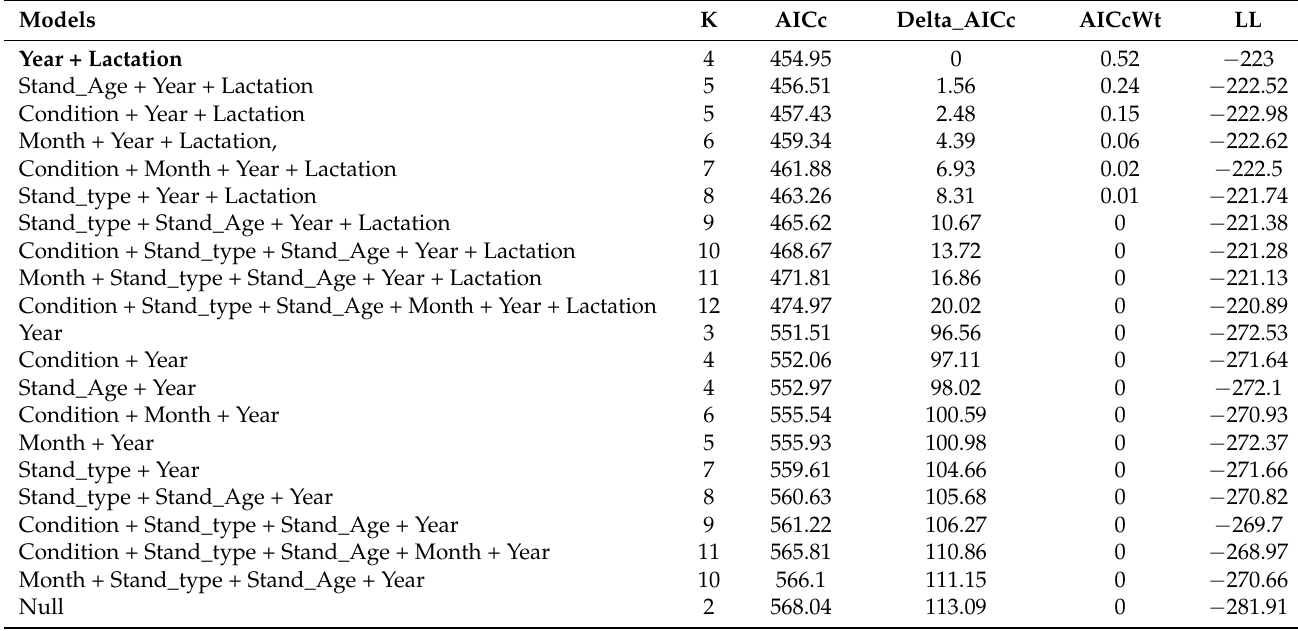
Table A5. Selection of linear models, based on Akaike criterion, explaining mushroom diversity consumed by adult female white-tailed deer on Anticosti Island, Qu é bec, Canada. For each model, the number of estimated parameters (K), the second order Akaike criterion adjusted for small sample size (AICc), the delta AICc and weight (AICcWt) as well as the log-likelihood are given. Tested models include various combination of deer body condition index and lactation status, forest stand type and age, as well as the month and year of harvest.